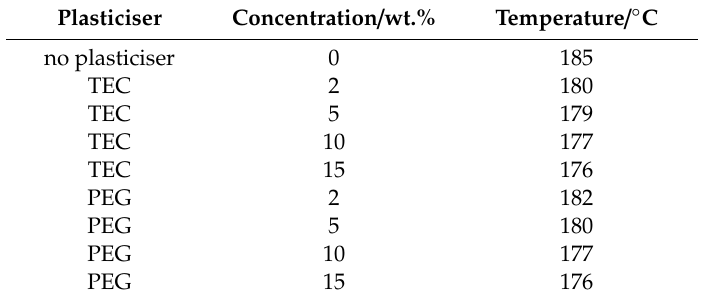
Table 3. Temperatures for constant melt flow rate. TEC: triethyl citrate, PEG: polyethylene glycol. Plasticiser Concentration/wt.%